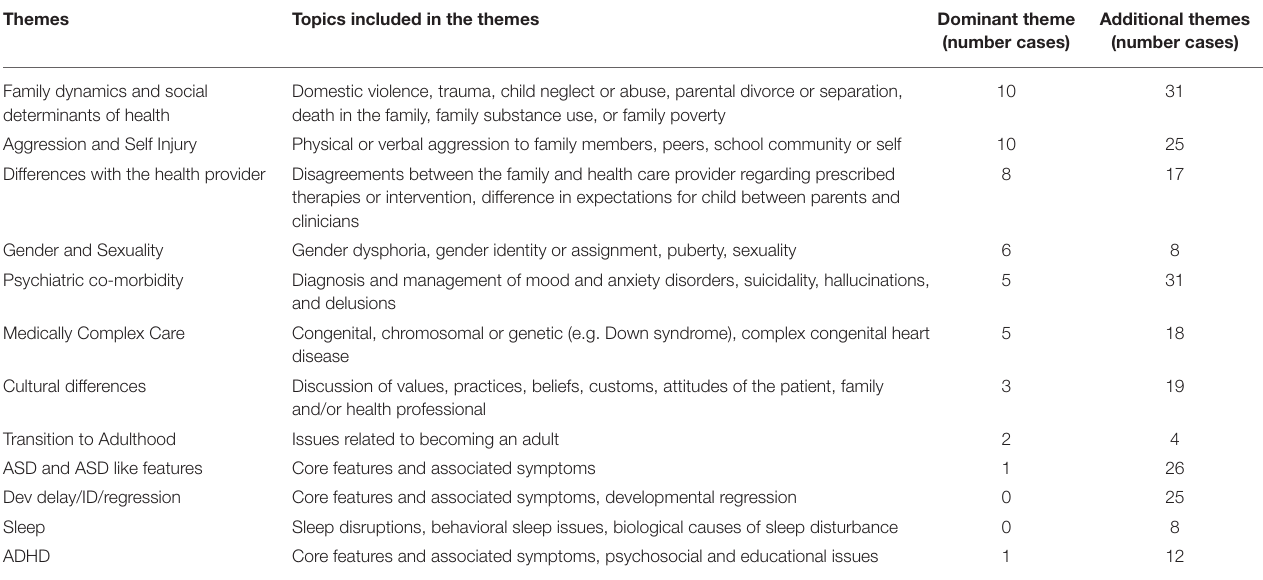
TABLE 2 | Themes from case